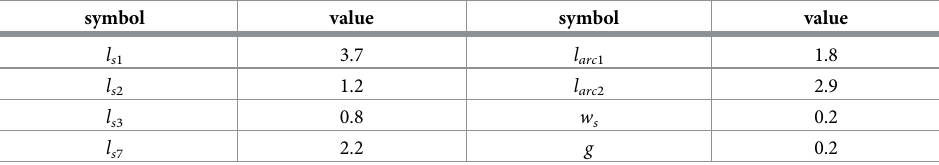
Table 3. Parameters of two notch structures in millimetres